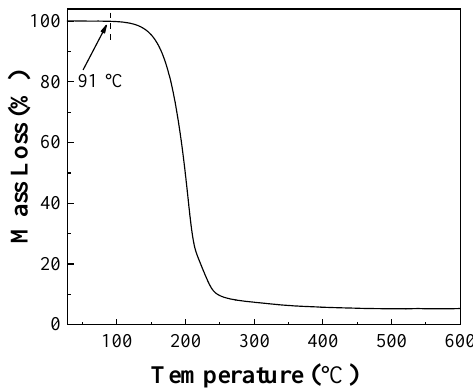
Figure 3. The TG curve of IPBC.